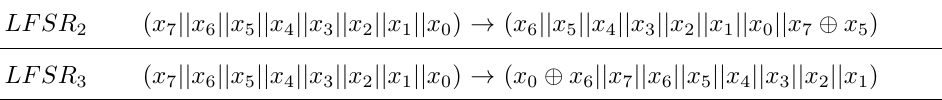
Table 3: The two LFSRs used in Deoxys-BC tweakey